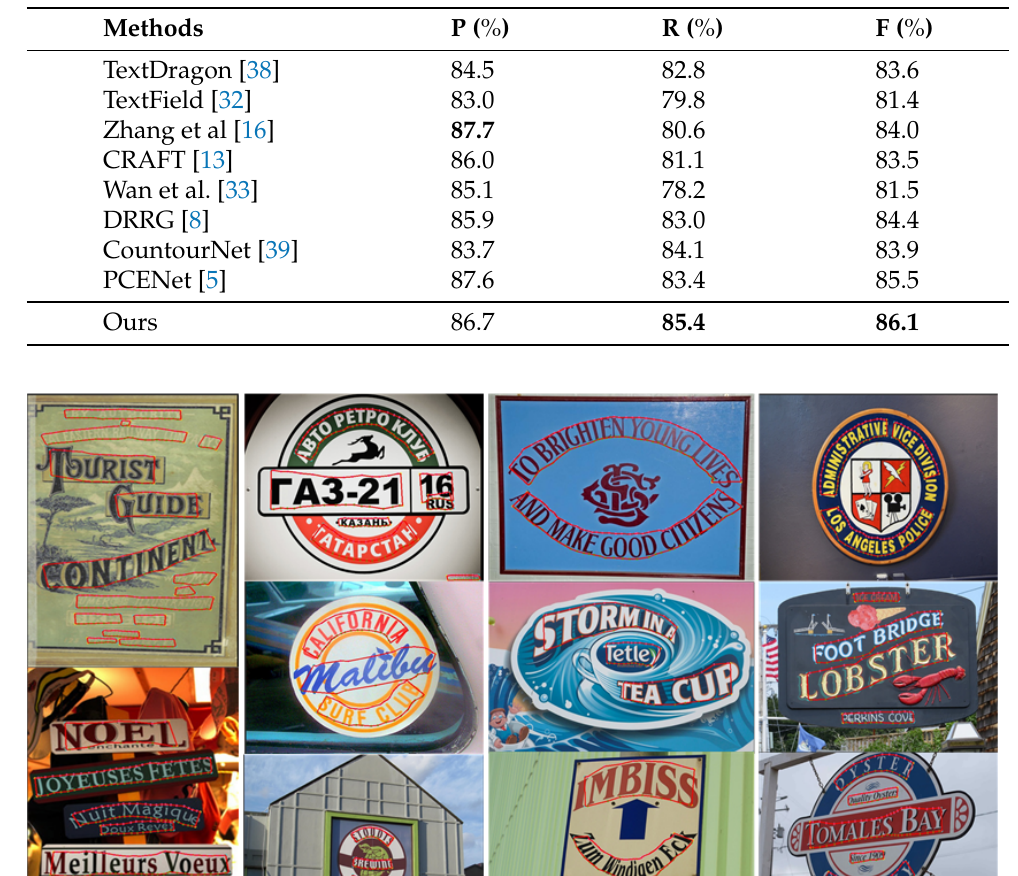
Table 5. Experimental results of various methods on the CTW-1500 dataset.